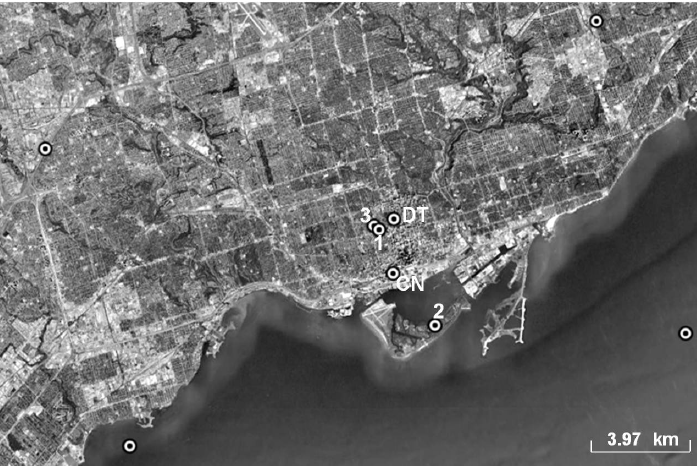
Fig. 1. Location of DT and CN monitoring sites characterized in Table 1. Location of MAX-DOAS instrument during campaigns in Table 2: 1=Wallberg Building, 2=Centre Island, and 3=McLennan Physics Building. The four points surrounding the MAX-DOAS and in situ measurement locations refer to the corners of a 13km × 24km OMI pixel with its area centred on